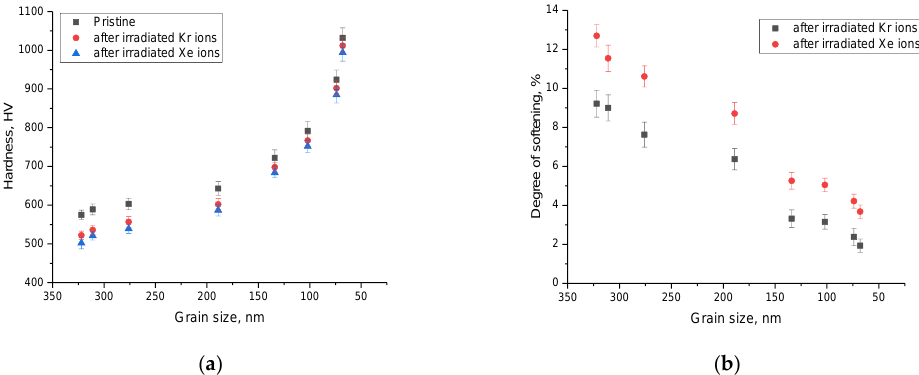
Figure 9. ( a ) Results of changes in the hardness of the near-surface layer before and after irradiation; ( b ) Results of changes in the near-surface layer softening value as a result of irradiation.